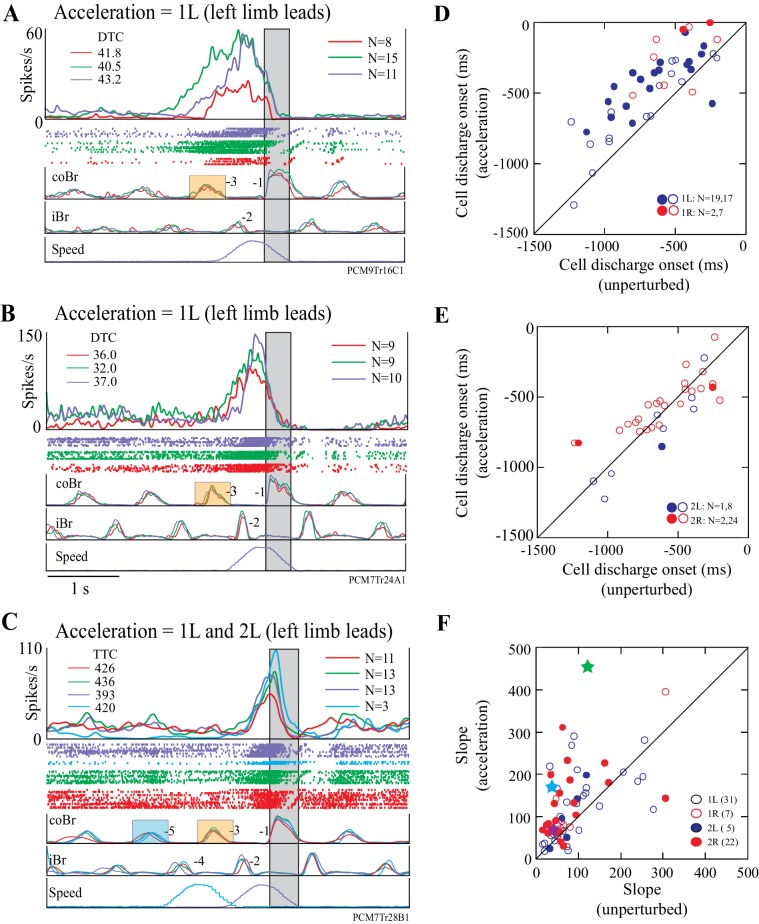
Examples and summary of effects of acceleration.(A,B) Example discharge of two DTC-related cells to acceleration of the obstacle in the 1L condition. (C) Example of a TTC-related cell to acceleration in the 1L and the 2L conditions. Figures organized as for Figure 7C. (D,E) Onset of cell discharge during accelerations as a function of the onset during the unperturbed visual dissociation task. Values are relative to the onset of the coBr during the step over the obstacle. (D), accelerations 1 step before (1L, 1R); (E), 2 steps before (2L, 2R). Filled circles in (D,E) indicate cells showing a significant change in the two conditions as determined by a t-test (p<0.05); open circles indicate non-significant values. (F) Slope of the cell discharge during the acceleration as a function of the slope during the unperturbed visual dissociation task. Slopes from all four acceleration conditions are illustrated (see key). Stars indicate the examples illustrated in Figures 7C and 8A,B (see text). Slopes were calculated from averaged traces as (max discharge– discharge at cell onset)/Δt. Boxes on the coBr trace in A-C indicate the burst used to trigger the acceleration. (Figure 8—source data 1 and 2).10.7554/eLife.28143.030Figure 8—source data 1.Source data for graphs in Figure 8D,E.10.7554/eLife.28143.031Figure 8—source data 2.Source data for graph in Figure 8F.10.7554/eLife.28143.032Figure 8—source code 1.Script for data in Figure 8.